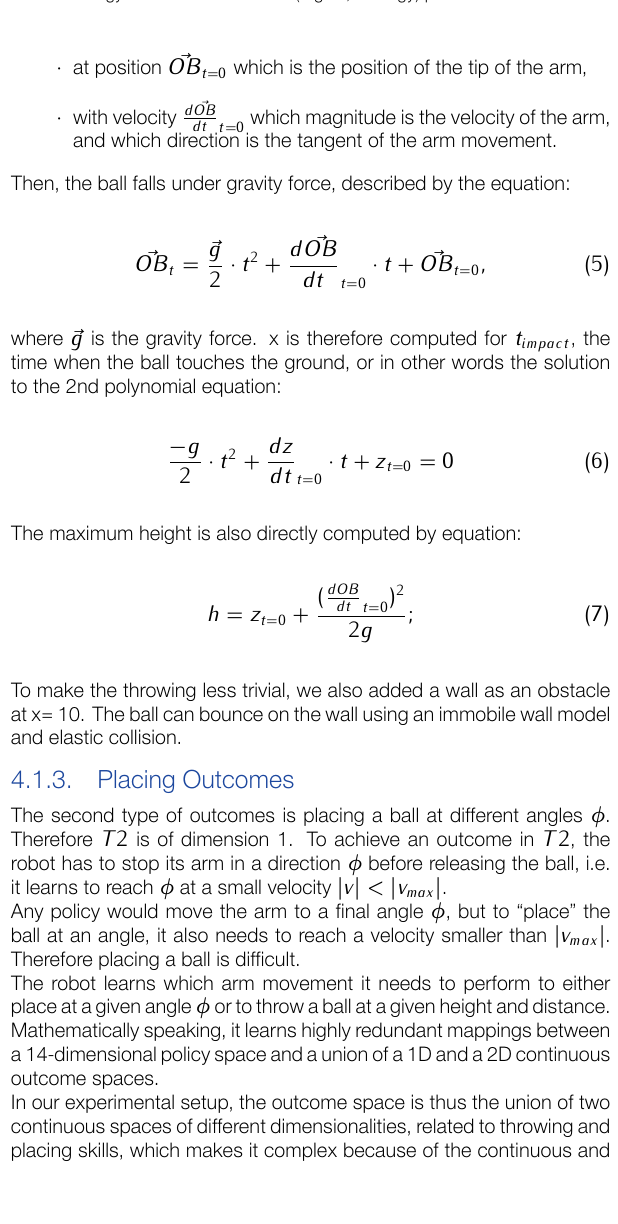
to which are associated R i